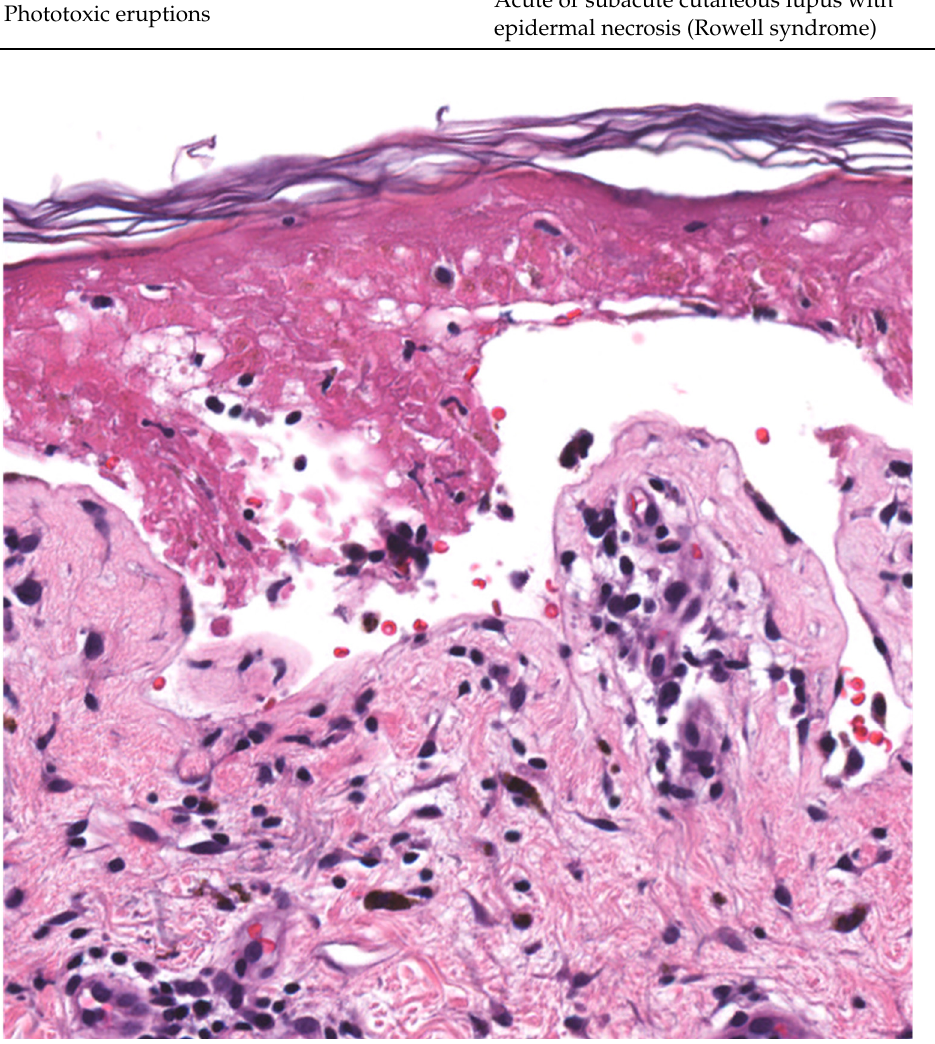
Figure 2. Histopathology of Stevens–Johnson syndrome. Full thickness epidermal necrosis, an orthokeratotic stratum corneum, and sparse dermal inflammation are typical and supportive but nonspecific features.